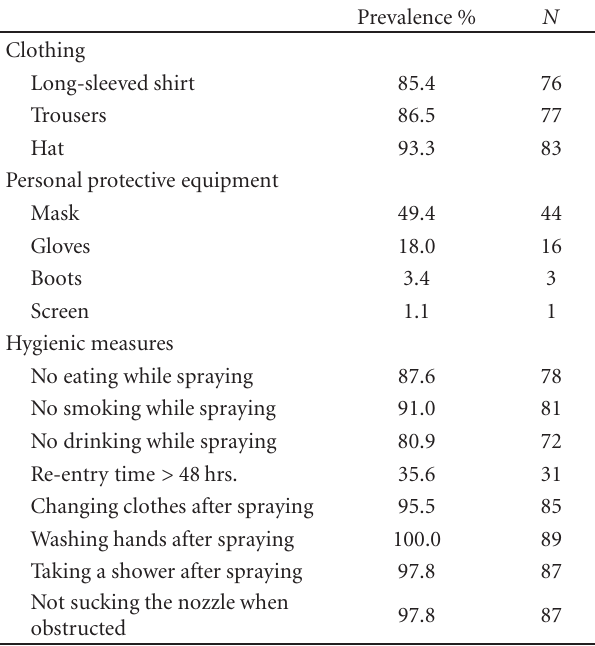
Table 4: Reported self-perceived symptoms among 89 farmers in Boeung Cheung Ek Lake, Phnom Penh, Cambodia.